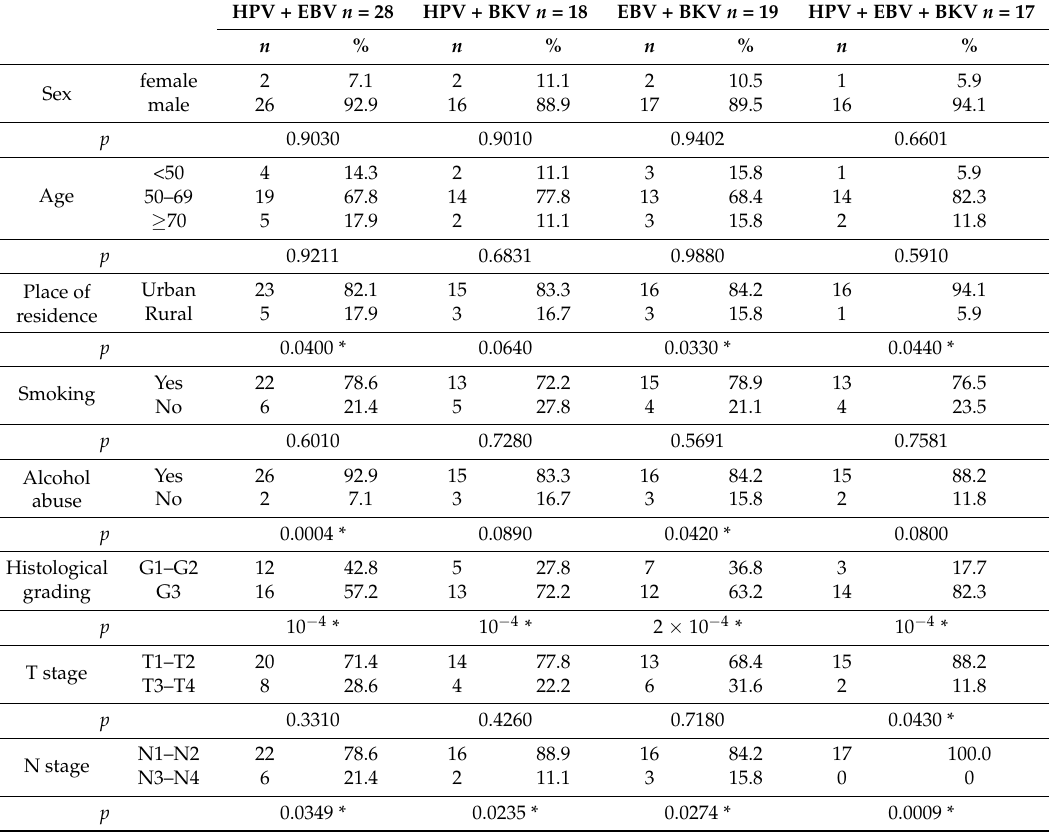
Table 4. Epidemiological and clinical characteristics of coinfected patients.